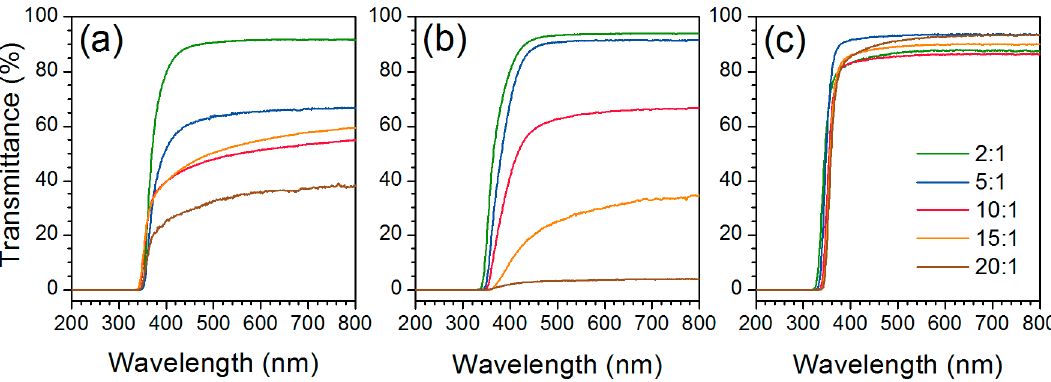
Figure 7. UV-vis spectra of mould-casted Ti-PDMS hybrid films (shown in Figure 1) prepared using PDMS-OH with viscosities of ( a ) 25 cSt, ( b ) 65 cSt and ( c ) 750 cSt for different TIP/PDMS-OH molar ratios.